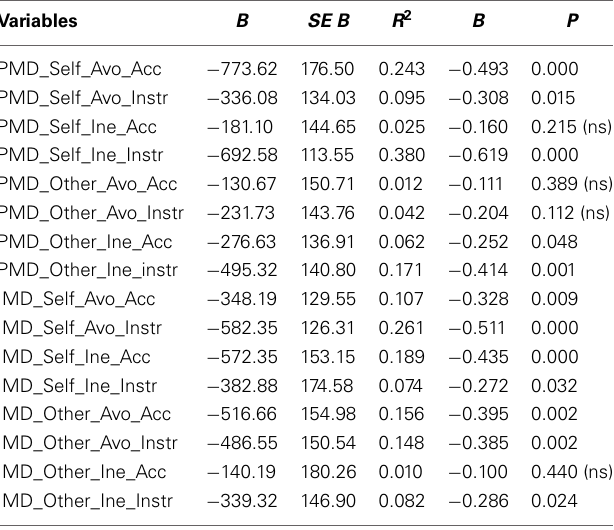
Table 4 | Summary table of the regression analysis of arousal ratings as predictors of the arousal ratings’ RT for each of the 16 dilemma